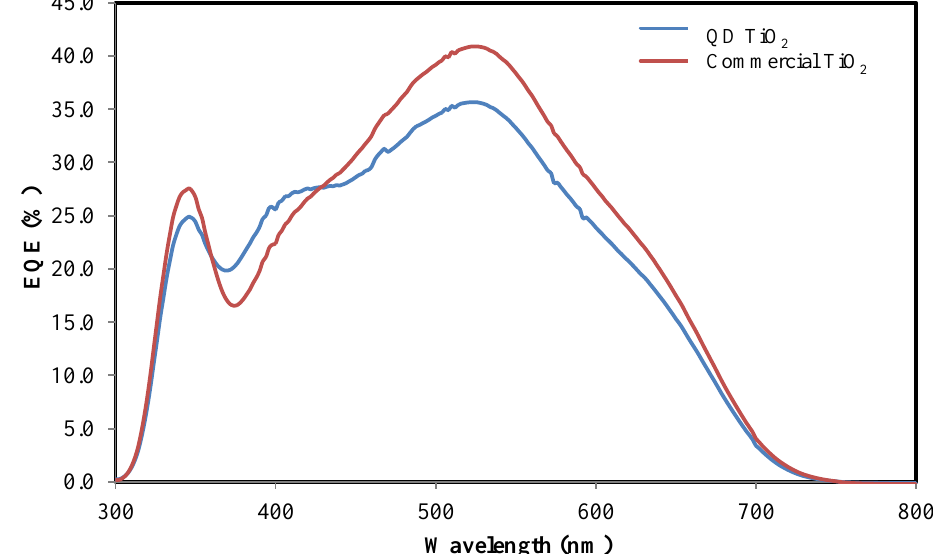
Figure 7. IPCE analyses of the QD TiO 2 and commercial TiO 2 nanoparticle-based DSCs.